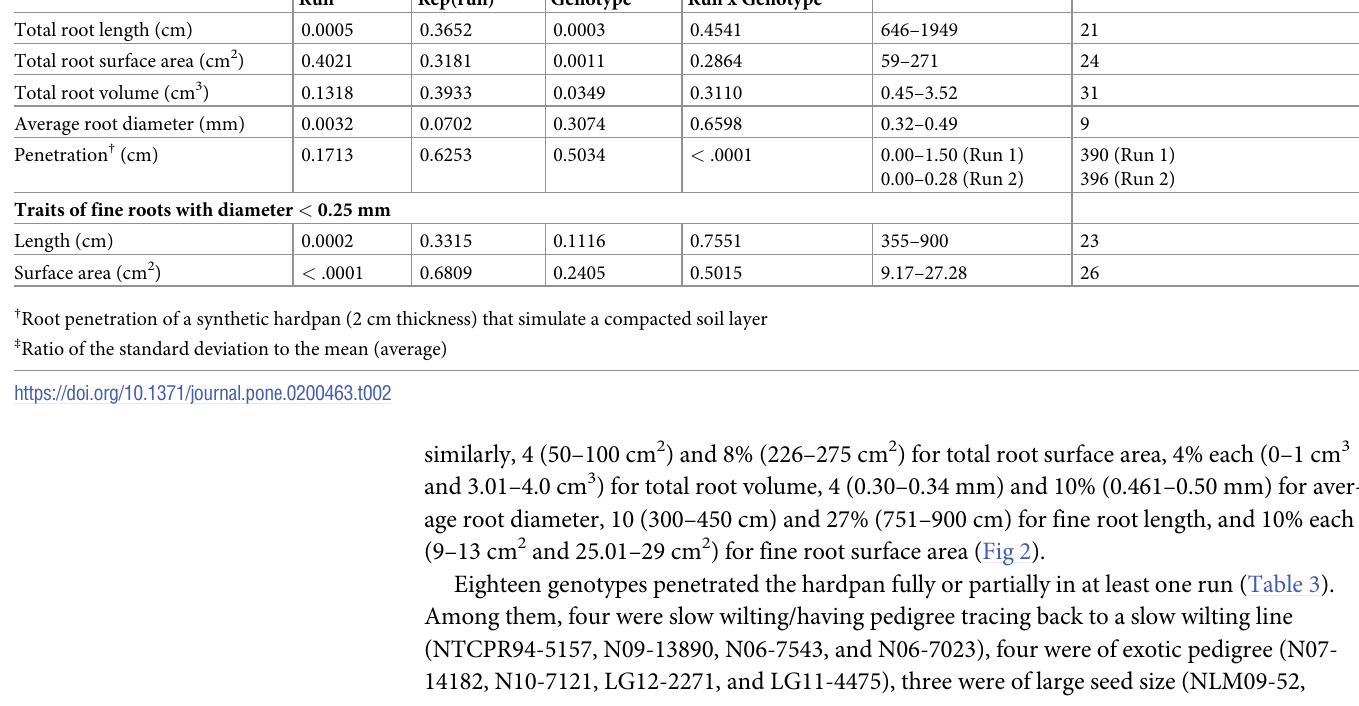
Table 2. Analysis of variance results on effects of run (the study was conducted two times, which were designated as two runs), rep(run), genotype, and run x geno- type interaction and range for various root traits. Trait